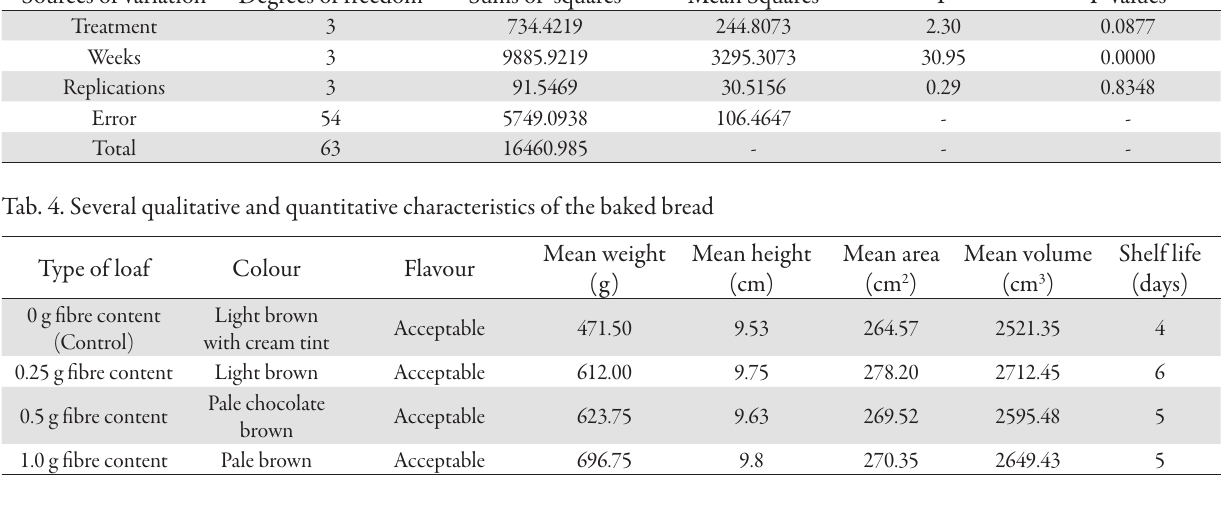
Tab. 3. The results of ANOVA conducted on the mean live weights of the rats Sources of variation